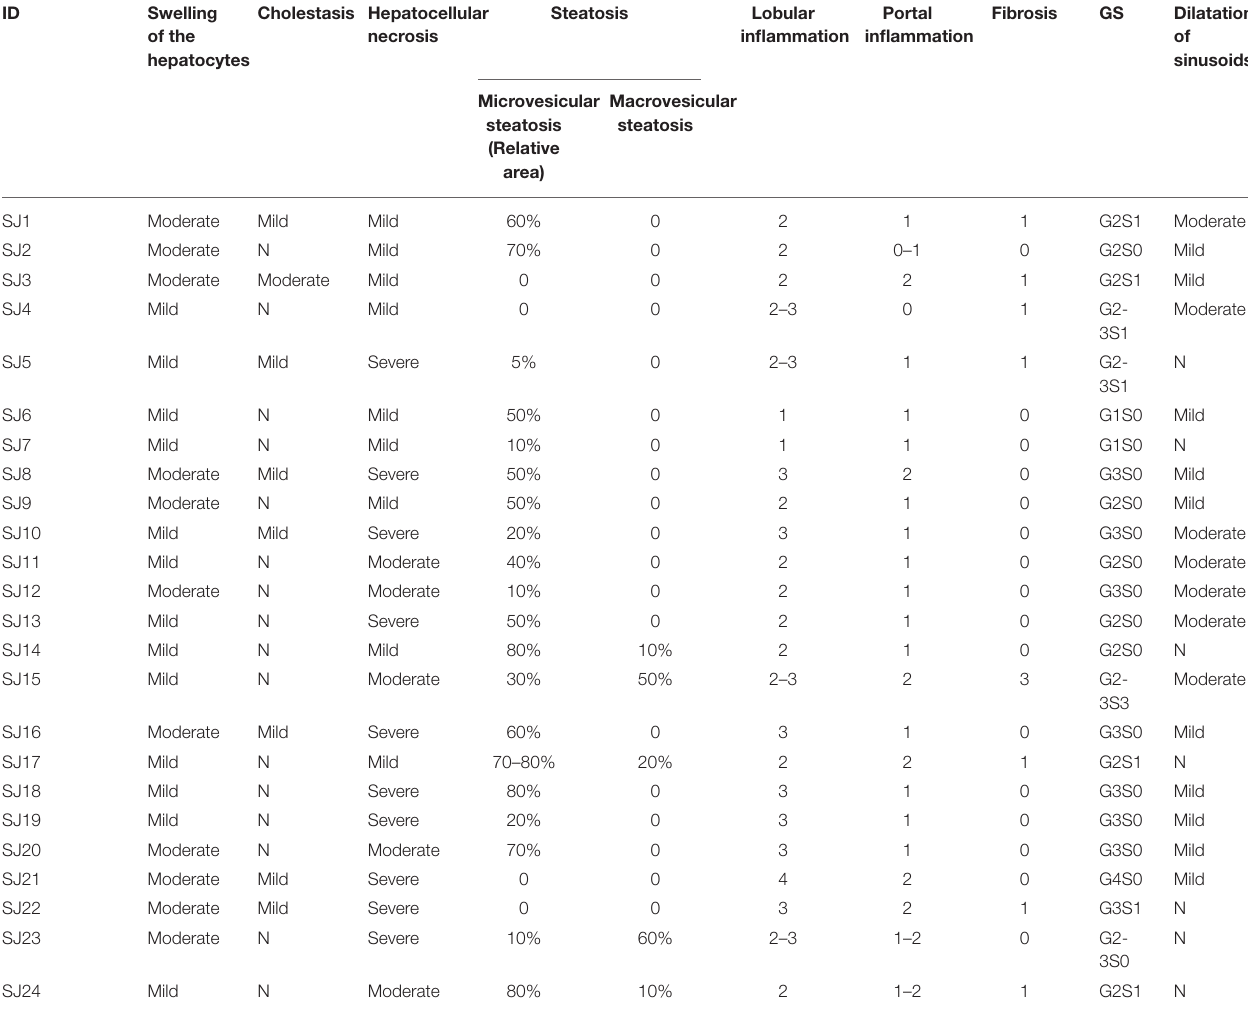
TABLE 3 | The pathologic abnormalities of liver using light microscopy observations in 24 cases of deceased patients with COVID-19.